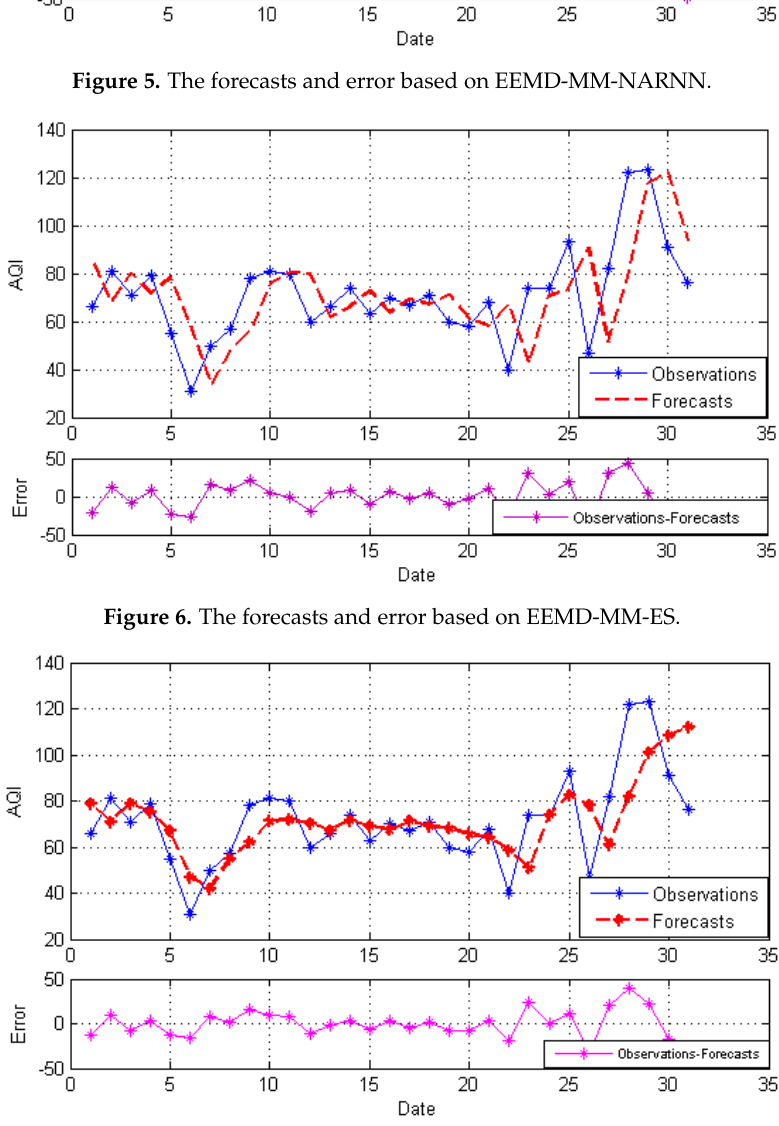
Figure 7. The forecasts and error based on